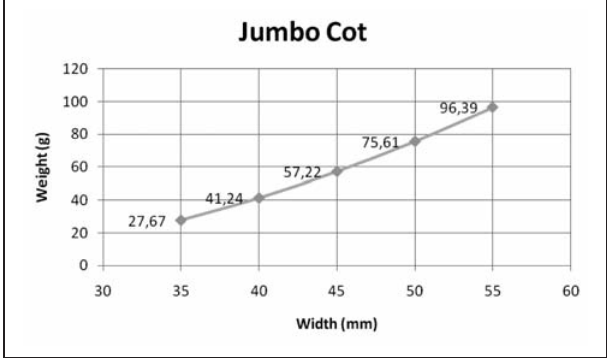
Fig.18. The connection of the measured data with the width for Jumbo Cot apricot